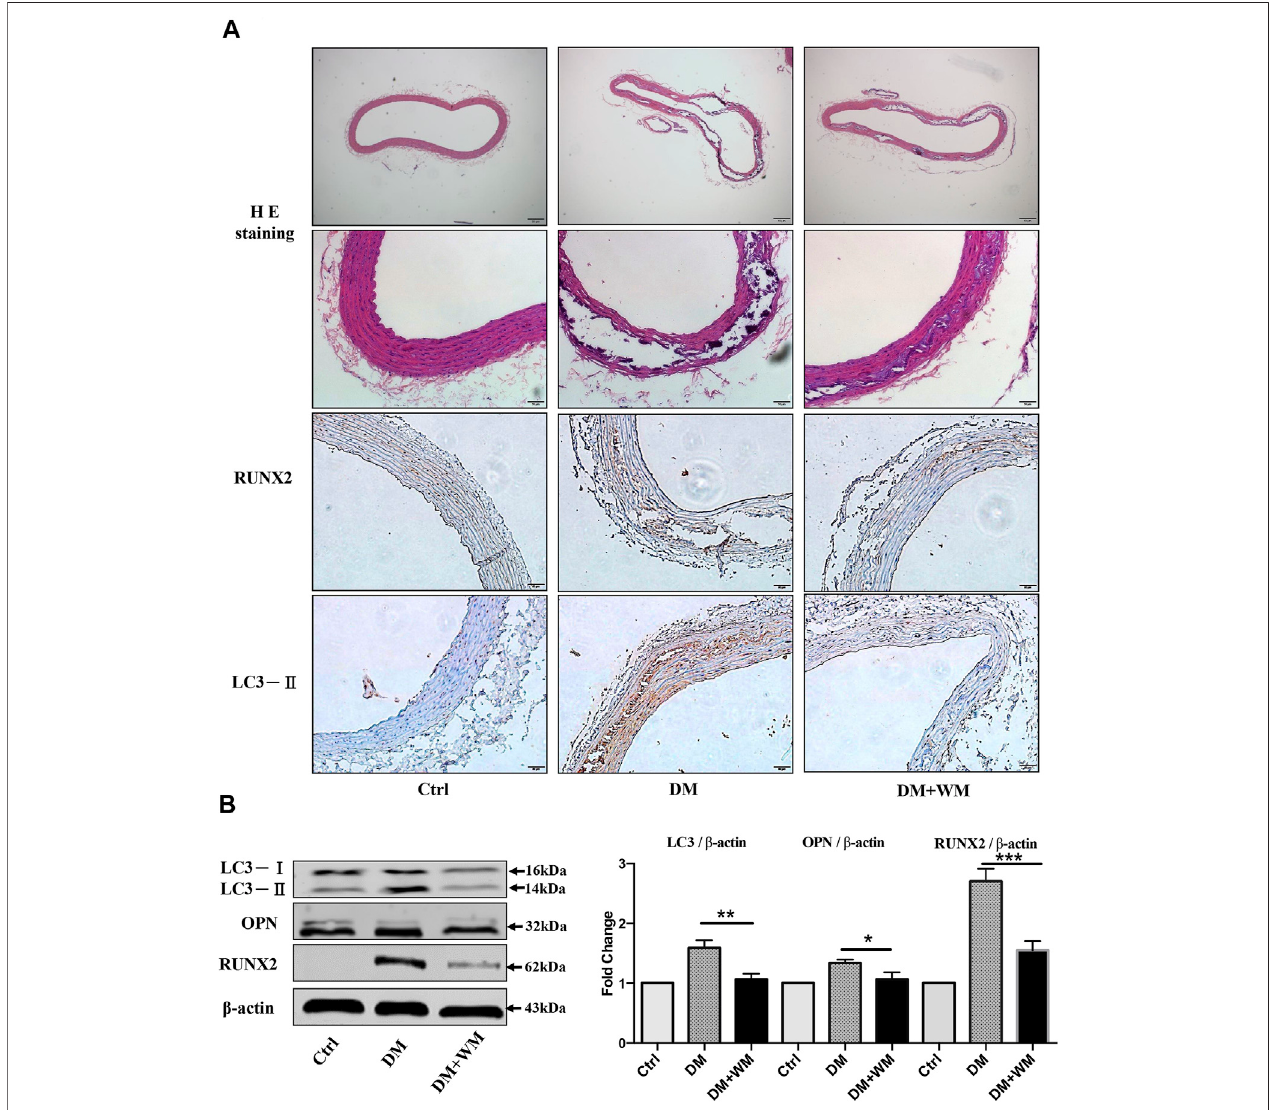
FIGURE 8 | Autophagy suppression rescues aortic calci fi cation in vivo . (A) Representative images of HE and immunohistochemistry-stained aorta sections are shown. Areas of calci fi cation lesions are shown with black and white tissues in detailed HE images at higher magni fi cation. Immunohistochemistry images stained with RUNX2, and LC3-II are shown in lower panels. Tissues with brown color stand for the positive signal for corresponding antibodies. Scale bar (cid:2) 50 μ m ( × 10), scale bar (cid:2) 10 μ m ( × 20). (B) Western blotassay from the homogenized samplesfrom the same aortasections wasdetected.The expression ofLC3-II wassigni fi cantly higher in the DM group than WM co-treated group. Besides, RUNX2 and OPN expression in aortic tissue signi fi cantly decreased than in the DM group.